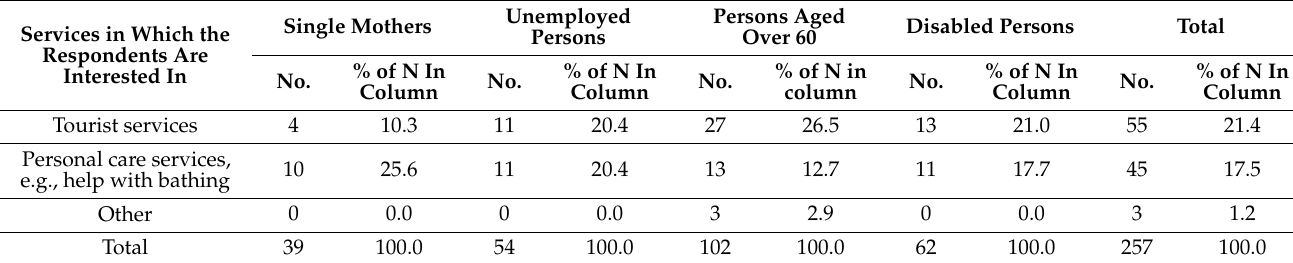
Table 13. Interest in using services available as part of the portal addressed to seniors and persons with disabilities, by social status of the respondents ( n = 521).